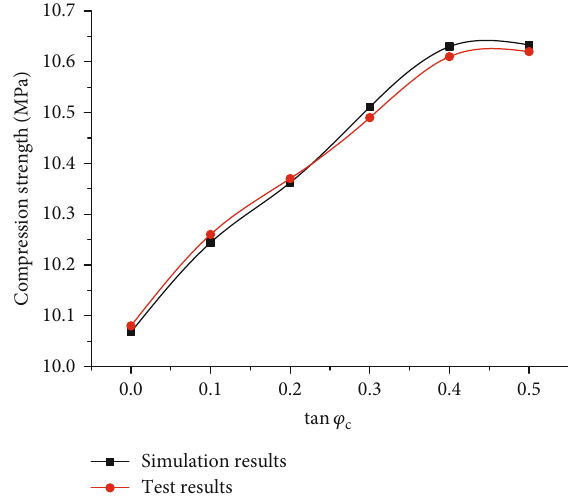
Figure 9: Uniaxial compression strength